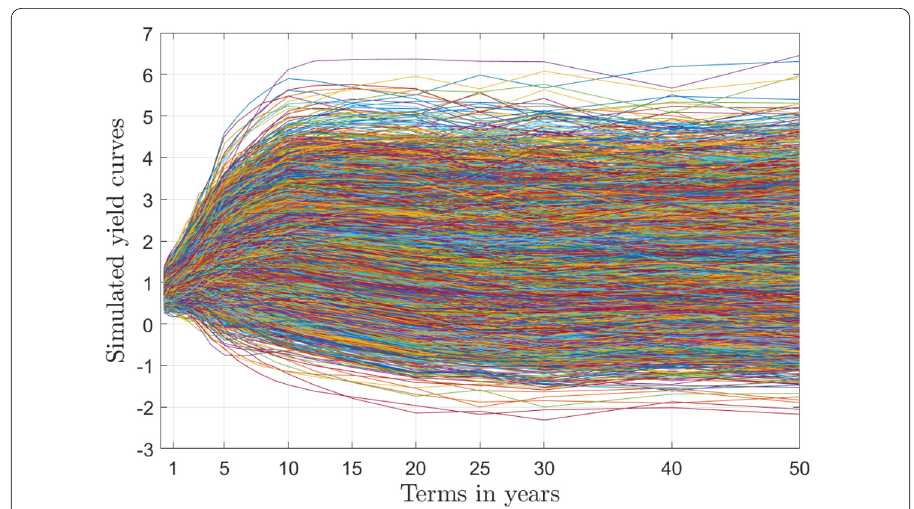
Figure 3 10,000 parameter vectors a ( t ) as a piecewise function of time